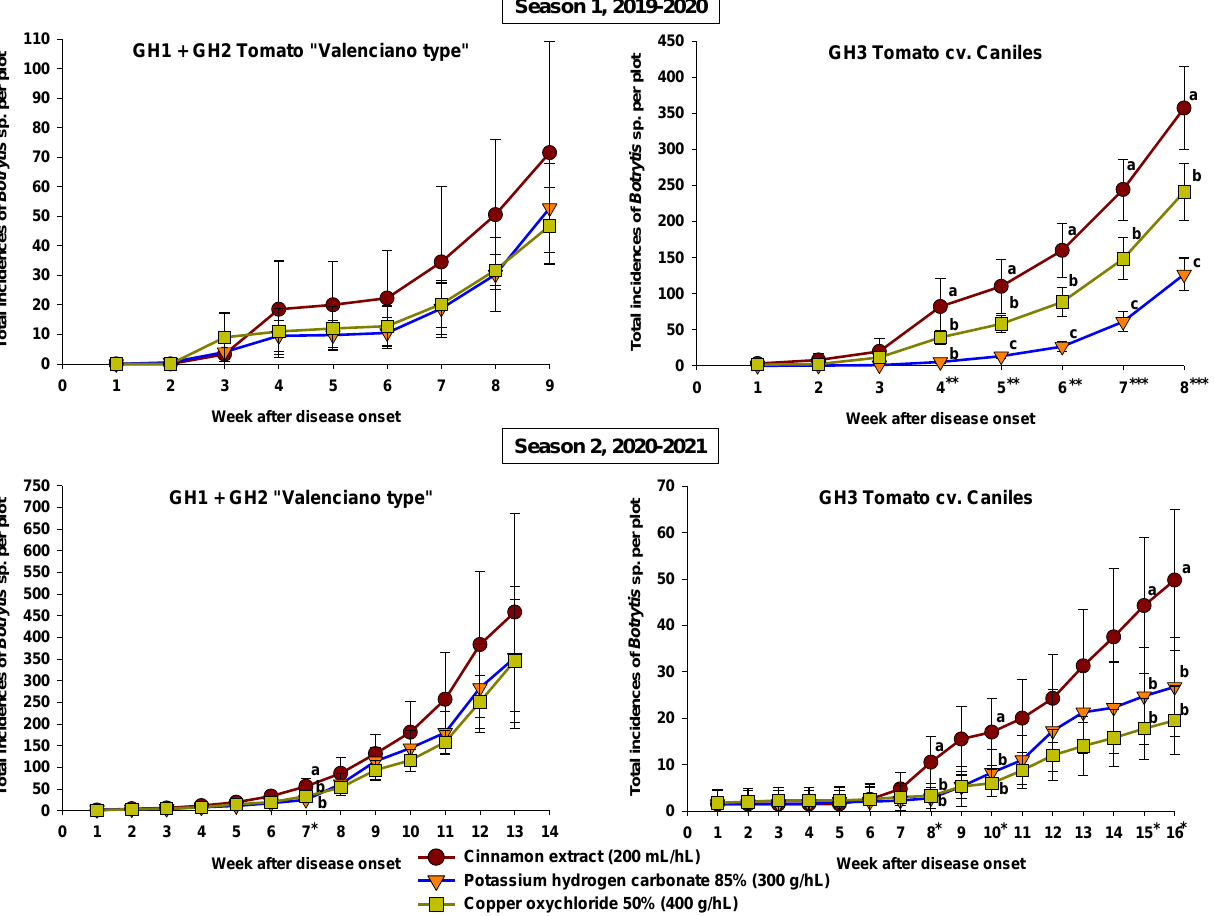
Figure 4. Accumulated incidence of grey mould on plants of tomato “Valenciano-type” and cv Caniles for Season 1 and Season 2 depending on treatment. Values are mean ± standard deviation; n = 4. Different letters in the same week indicate significant differences ( p ≤ 0.05, Fisher’s LSD test). “*”, “**”, and “***” indicate significance at p ≤ 0.05, 0.01, and 0.001, respectively.